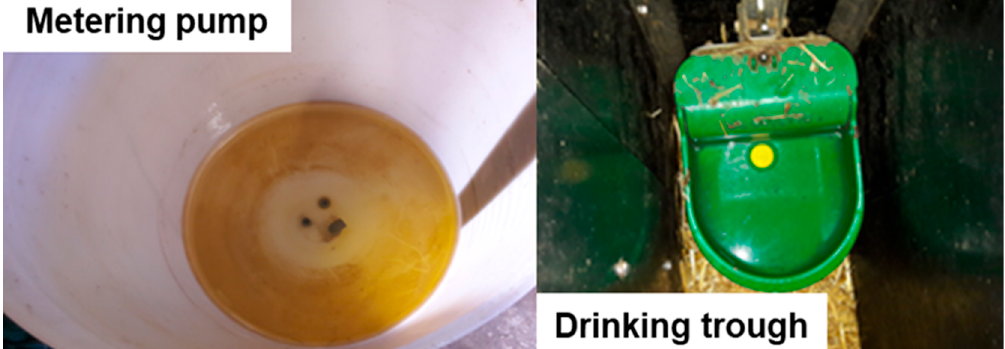
SDM treatment of 200 lambs for 5 days via the drinking water (Emericid ® Sulfadimethoxine,